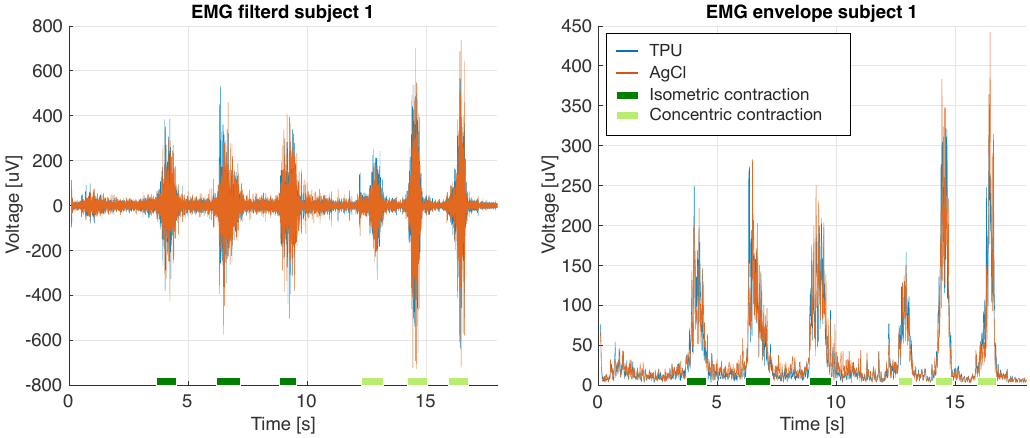
Figure 10. EMG measured by the printed D16_IED20 and AgCl electrodes for a given subject performing three isometric contractions followed by three concentric contractions.